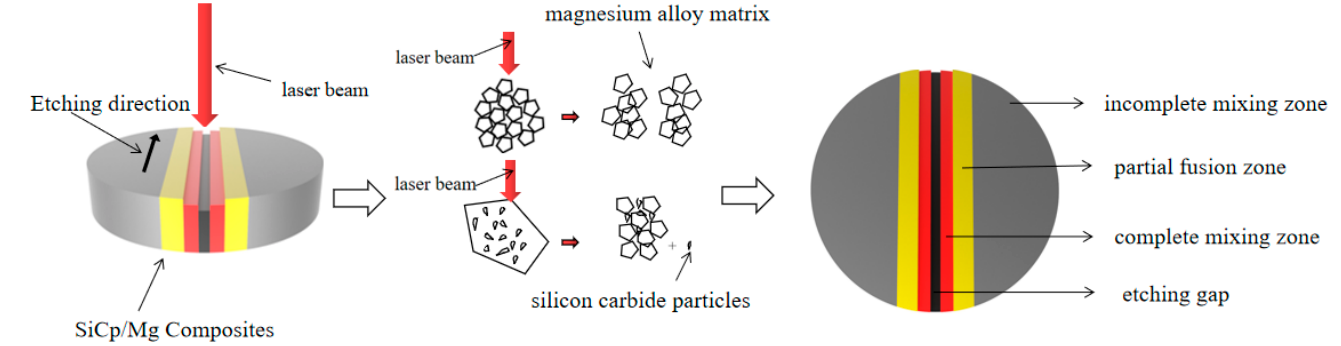
Figure 12. Schematic diagram of the formation of the impact zone of laser-etched SiC p /Mg composites.